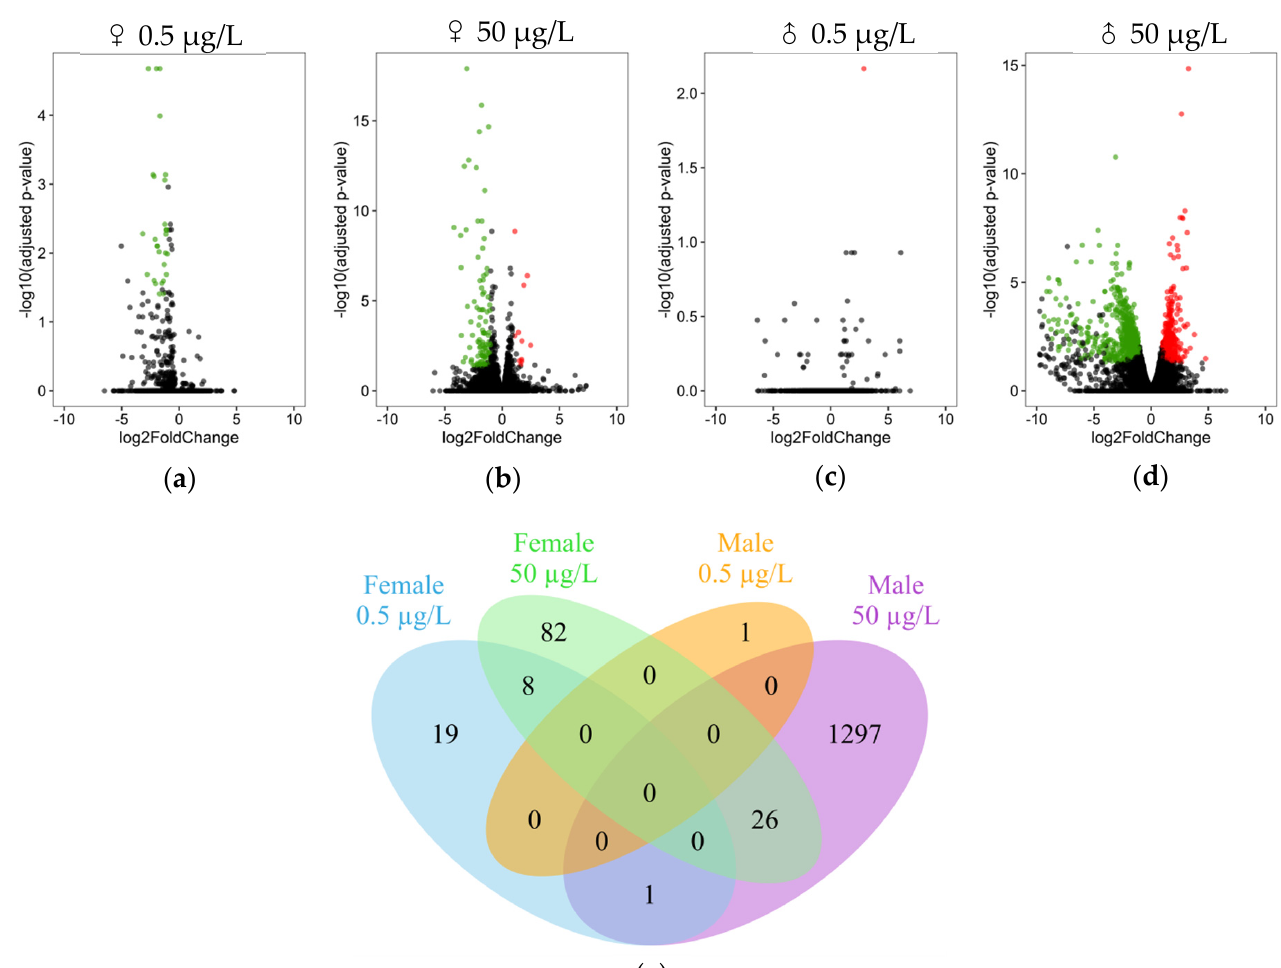
Figure 1. Differentially expressed genes (DEGs) in female ( a , b ) and male ( c , d ) copepods exposed to 0.5 µg/L ( a , c ) and 50 µL/L ( b , d ) of TEB. Genes with |FoldChange| ≥ 2 and an adjusted p -value ≤ 0.05 were considered mis-regulated. Down-regulated genes are represented in green and up-regulated genes in red. ( e ) Venn diagram of DEGs shared between sexes and TEB concentrations. Green and red dots respective down- and up- regulated genes with their log2FoldChange. If not significant, dots were grey.